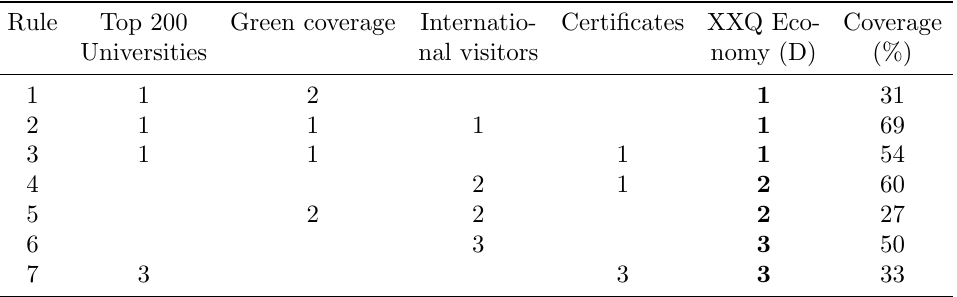
Table 7: Rough set rules explaining XXQ Economy by the most important single sub- factors Rule Top 200 Green coverage Internatio- Certificates XXQ Eco- Coverage